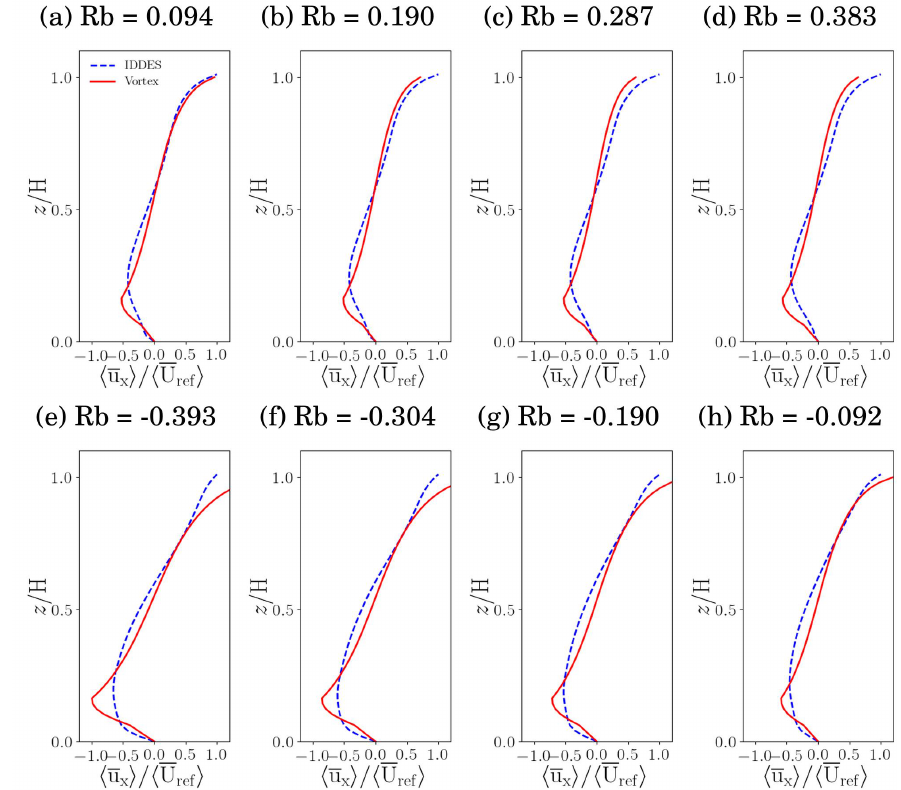
Figure 17. Vertical profiles of normalised streamwise velocities for AR = 1 and different Rb. ( Top ) Sta- ble stratification; ( bottom ) unstable stratification. Predicted (solid lines) and IDDES (dashed lines) results are compared at θ = 45°; the geometric constants were calculated at